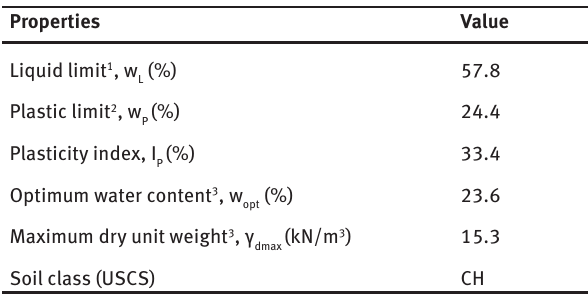
Figure 1: Toothbrush bristles (a) after cutting, (b) after mixing with Figure 1. Toothbrush bristles (a) after cutting, (b) after mixing with dry dry soil, (c) after adding optimum water soil, (c) after adding optimum water content. Table 1: Some properties of clayey soil used in tests.